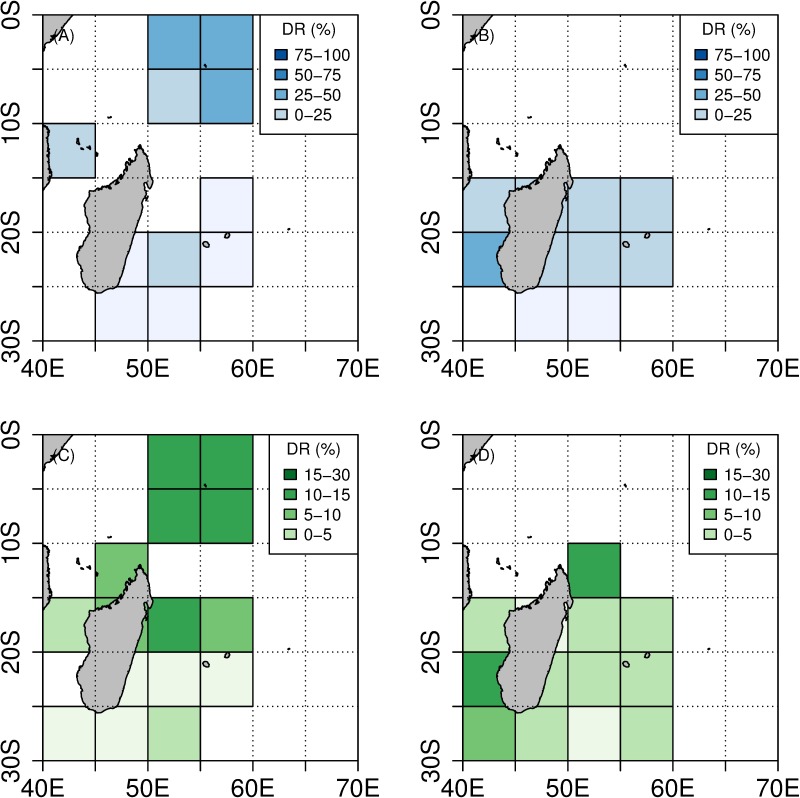
Distribution of DR* (in %).DRTW* is depicted in blue, DRSH* is depicted in green. (A) Distribution of DRTW* between 2004 and 2010. (B) Distribution of DRTW* between 2011 and 2015. (C) Distribution of DRSH* between 2004 and 2010. (D) Distribution of DRSH* between 2011 and 2015.